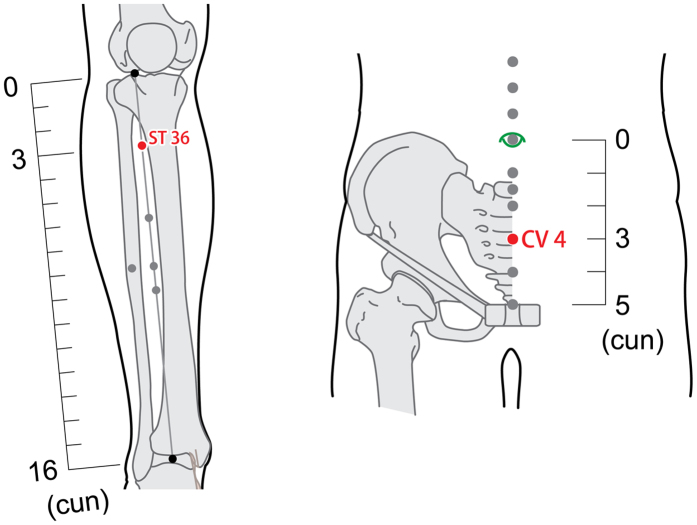
Acupoint locations.